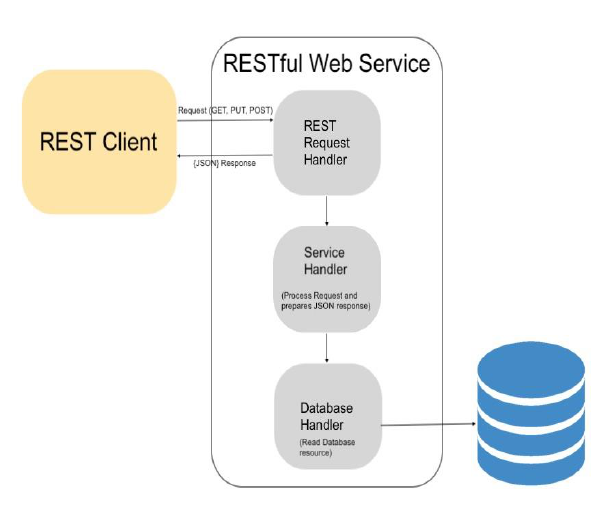
Figure 4: RESTful API architecture